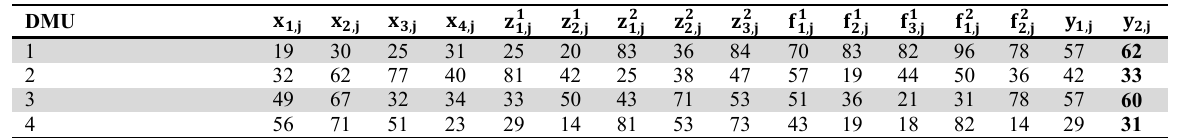
Numerical data for model 2